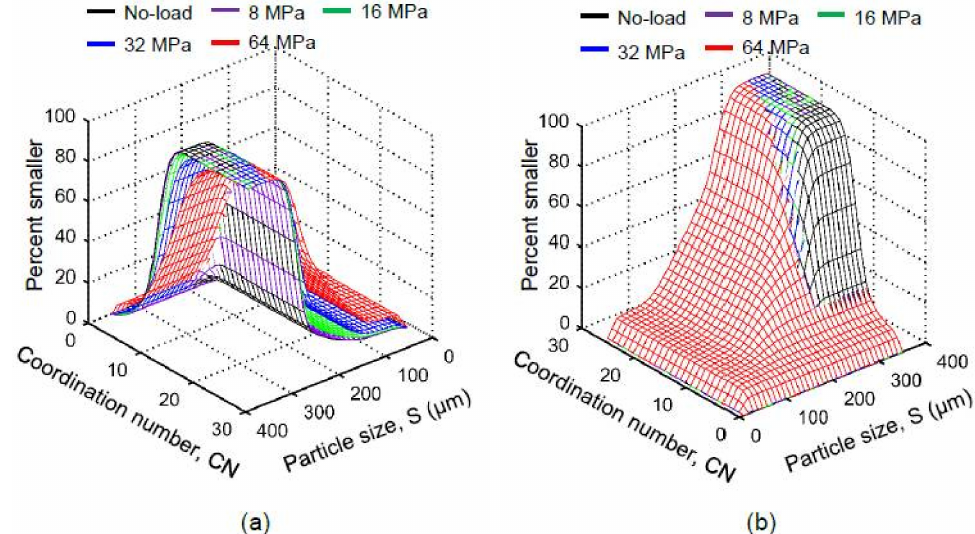
Figure 17. Particle size dependent distributions of coordination number for RBS particles at different vertical stresses: ( a ) view-1; ( b ) view-2 (180 ◦ rotation of view-1).